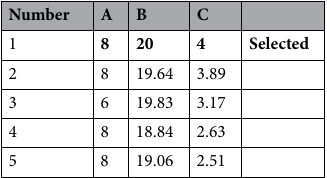
Table 6. Optimized geometry proposed by RSM.